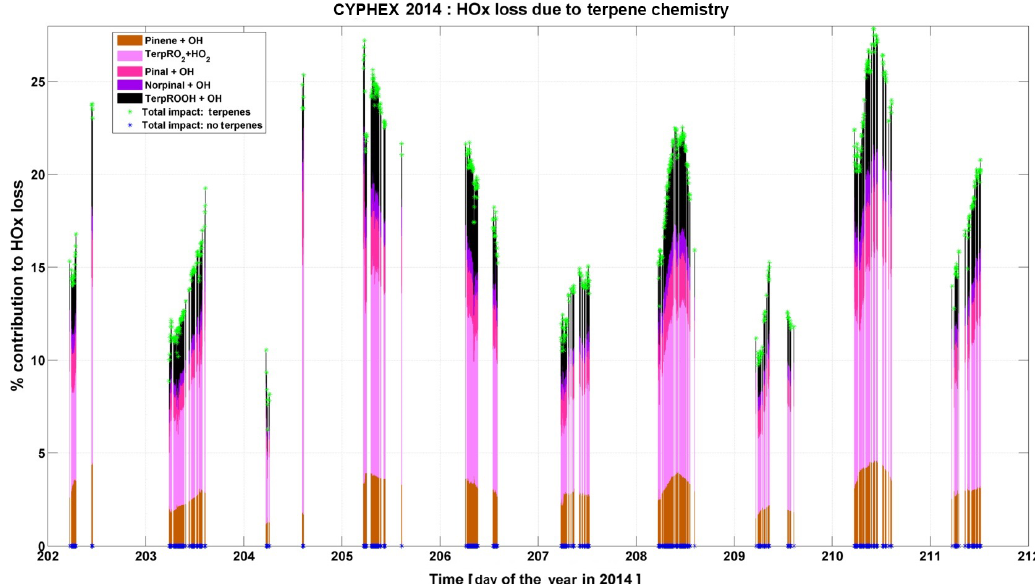
Figure 5. Contribution of different terpene-related reactions to the total HO x loss. Additional peroxy radicals are produced in the model by terpenes rather than organics, e.g. isoprene degradation. Pinene includes α -pinene and β -pinene. TerpRO2 includes only C 8 H 13 O 3